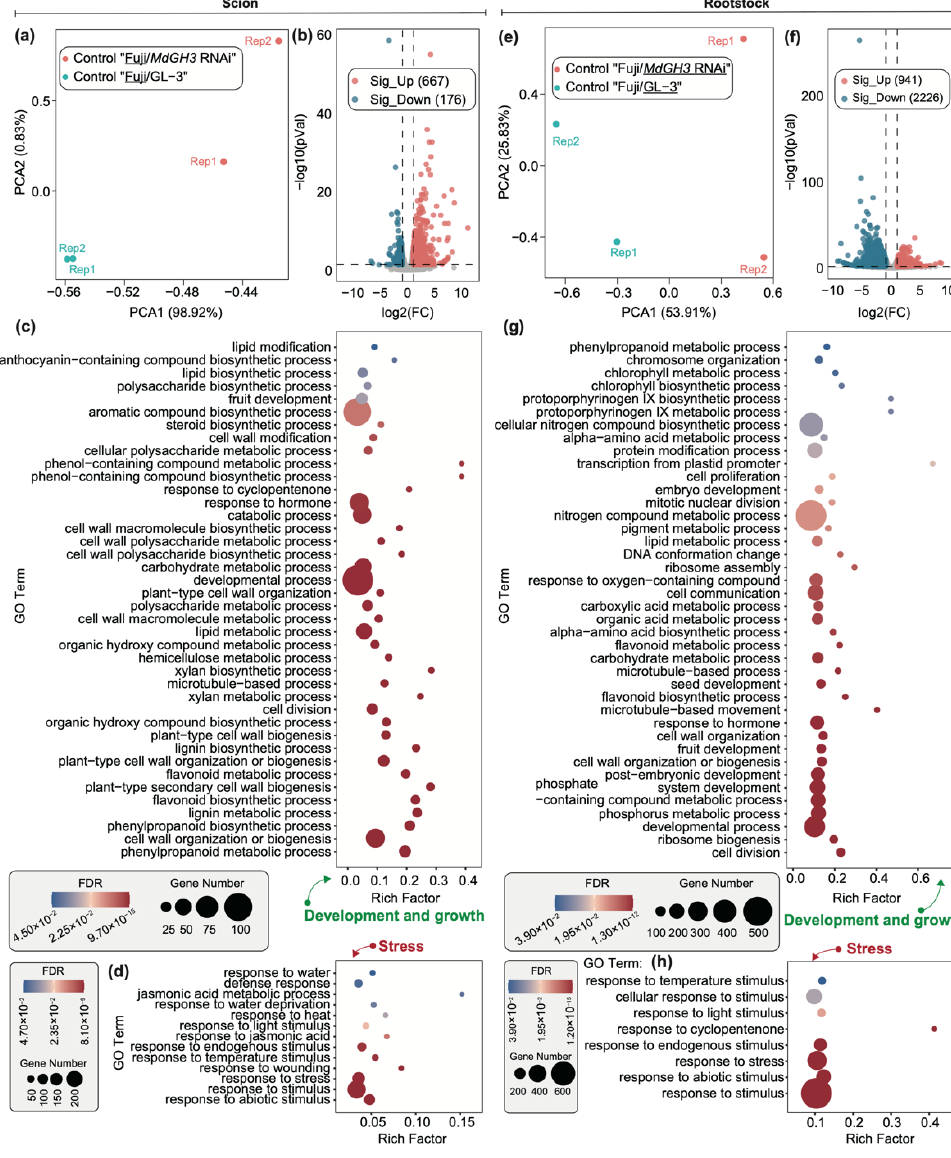
Figure 2. Differentially expressed genes (DEGs) in scion and rootstock of “Fuji/ MdGH3 RNAi” and “Fuji/GL-3” plants under control conditions. The left panel is the analysis of DEGs associated with scion, and the right one presents the DEGs associated with rootstock. ( a ) Principal component analysis (PCA) plot showing the variation between scion (“Fuji”) data of “Fuji/ MdGH3 RNAi” and “Fuji/GL-3”. ( b ) Volcano plot showing up-regulated genes and down-regulated genes in scion of “Fuji/ MdGH3 RNAi” compared to “Fuji/GL-3” under control conditions. ( c , d ) gene ontology (GO) enrichment analysis of DEGs in scion. ( e ) PCA plot showing the variation between rootstock of Fuji/ MdGH3 RNAi and Fuji/GL-3 data. ( f ) Volcano plot showing up- and down-regulated genes in MdGH3 RNAi rootstocks compared to GL-3 rootstocks. ( g , h ) GO enrichment analysis of DEGs in rootstocks. The GO enrichment analysis in ( c , d , g , h ) was divided into “development and growth” and “stress”